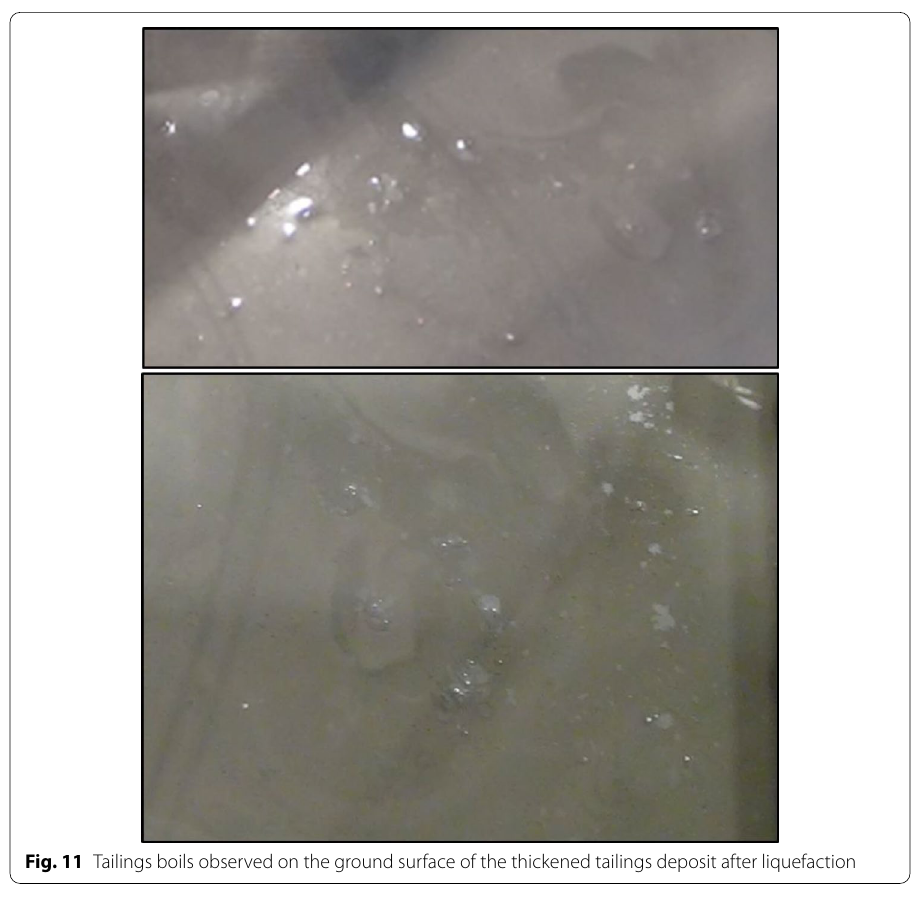
Fig. 11 Tailings boils observed on the ground surface of the thickened tailings deposit after liquefaction